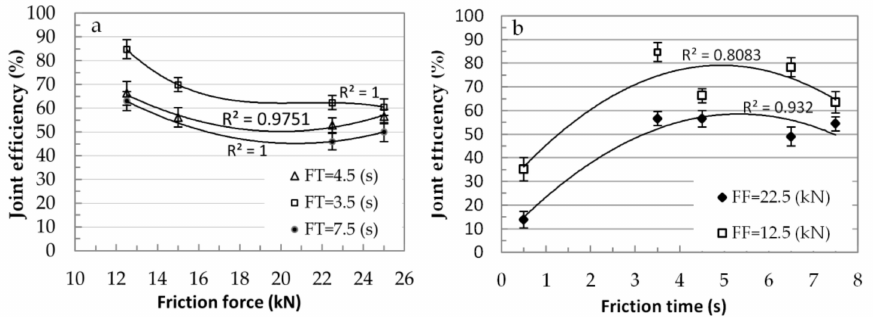
Figure 6. Effect of friction welding parameters on joint efficiency; ( a ) friction force vs joint efficiency, ( b ) friction time vs joint